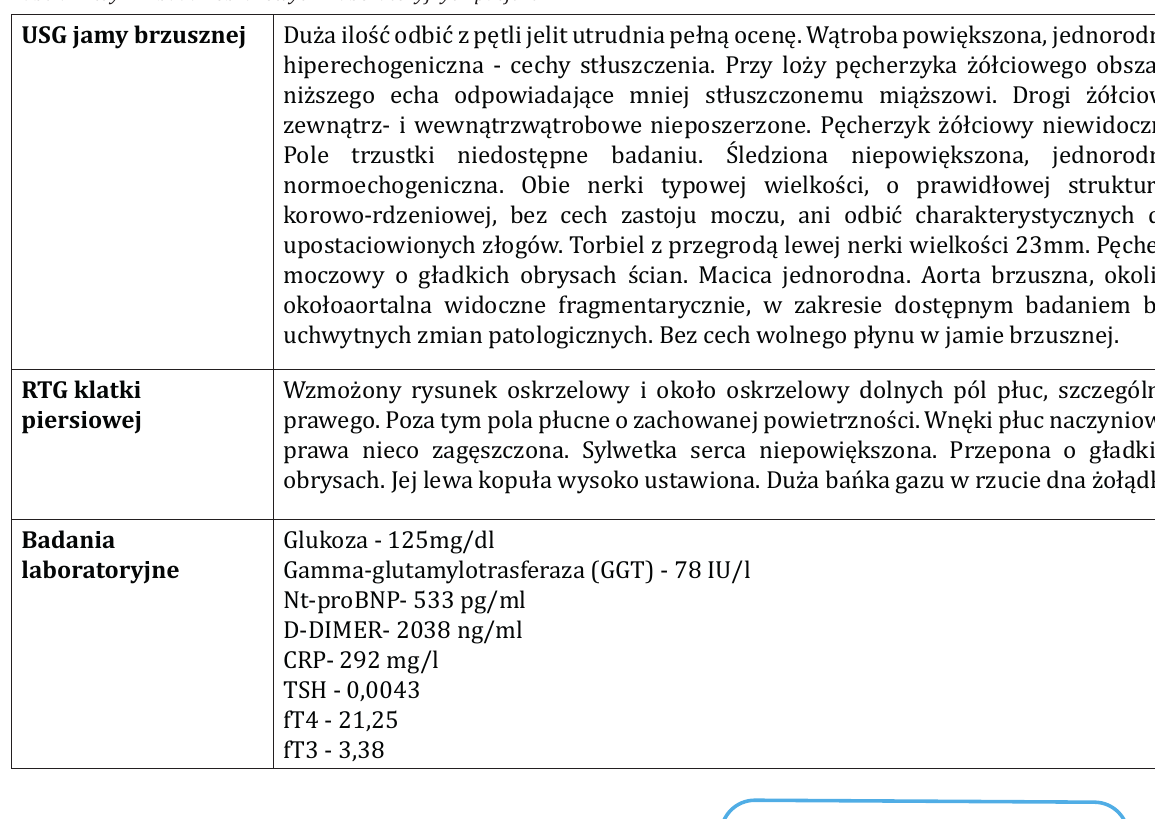
Tabela 1. Wyniki badań obrazowych i laboratoryjnych